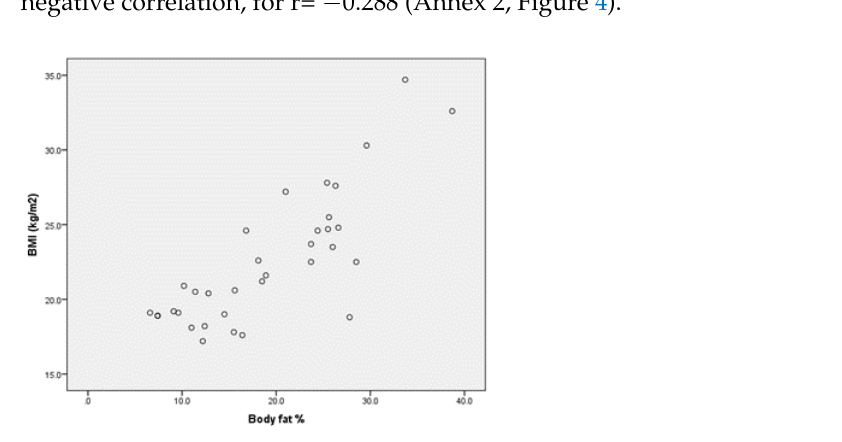
Figure 2. Correlation between BMI and muscle mass % for the group of boys without ID.